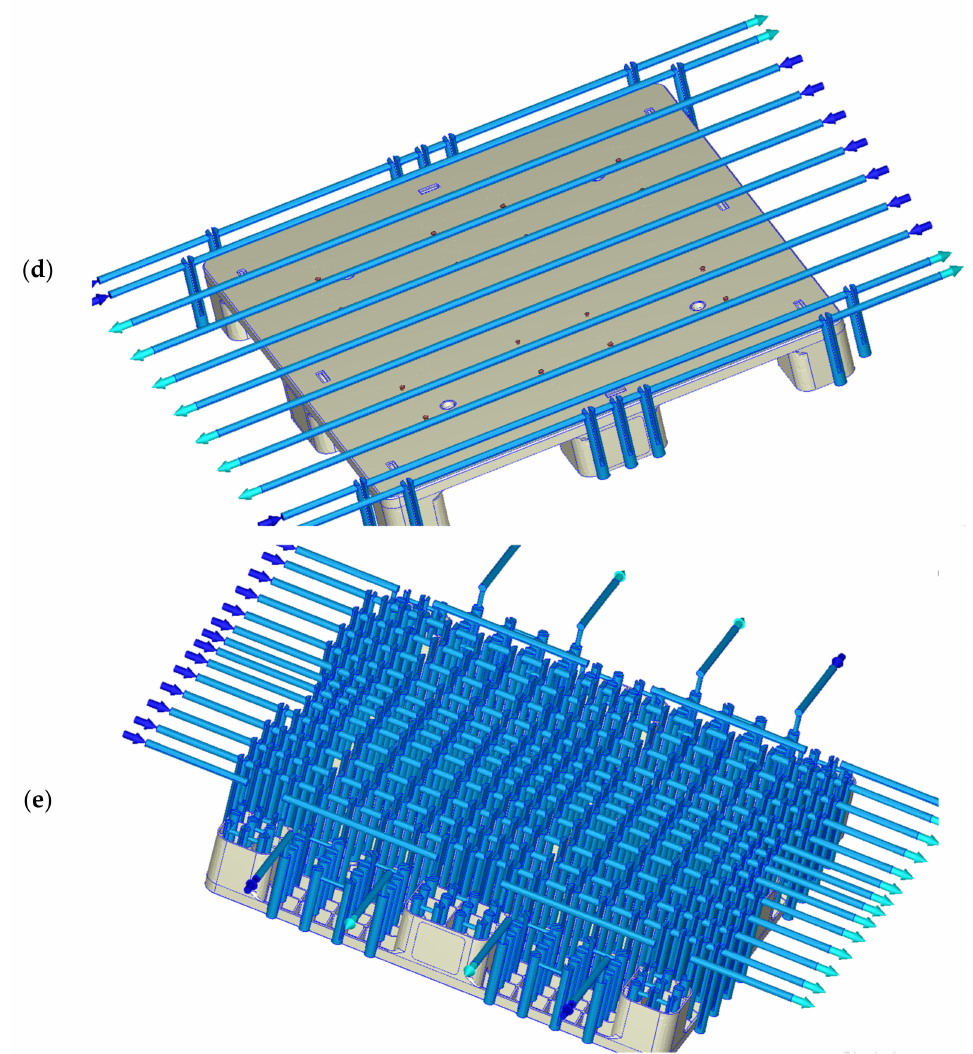
Figure 1. Injection-molded pallet (1000 mm × 1000 mm × 130 mm). ( a ) Sixteen filling gates in the pallet; ( b ) dimensions of the pallet (front view); ( c ) isometric view of the pallet (bottom side); ( d ) isometric view of the water flow system on the top side of the pallet; ( e ) isometric view of the baffle-cooling flow system on the bottom side of the